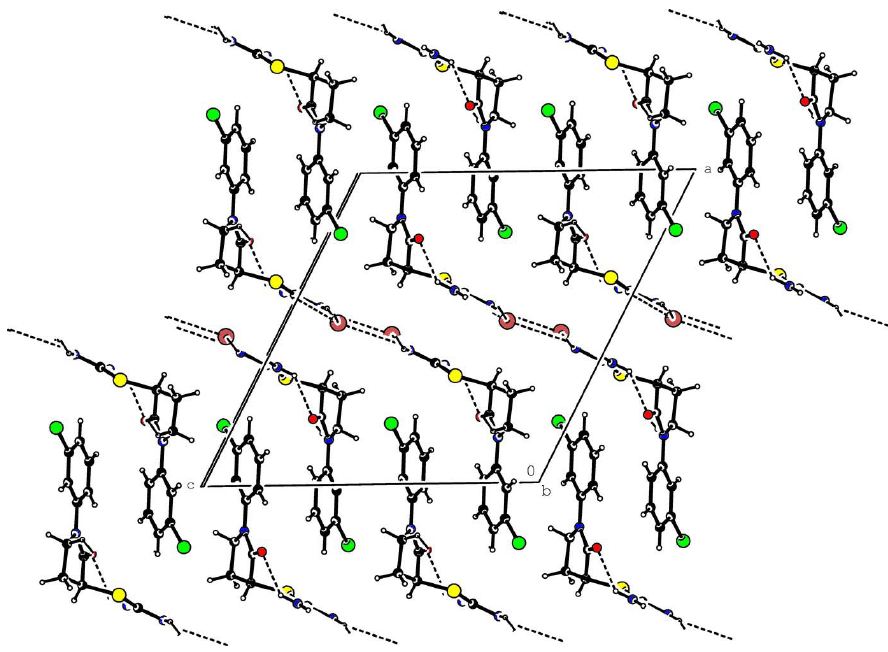
Figure 3 View of the unit cell along the axis c. The H bonding is depicted. Symmetry codes for Br1c: x, -1+y, z; for Br1d: 1-x, -1/2+y, 3/2-z; for another isothiuronium fragment: x, 1+y,